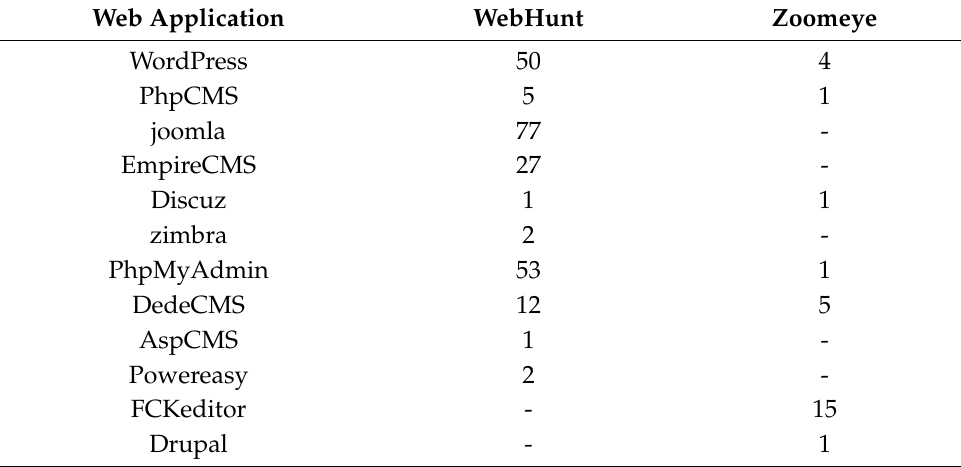
Table 14. Numbers of Web applications detected by WebHunt, Shodan, FOFA and Zoomeye. Web Application